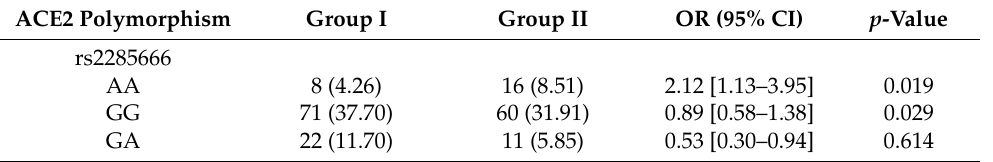
Table 3. ACE2 polymorphism